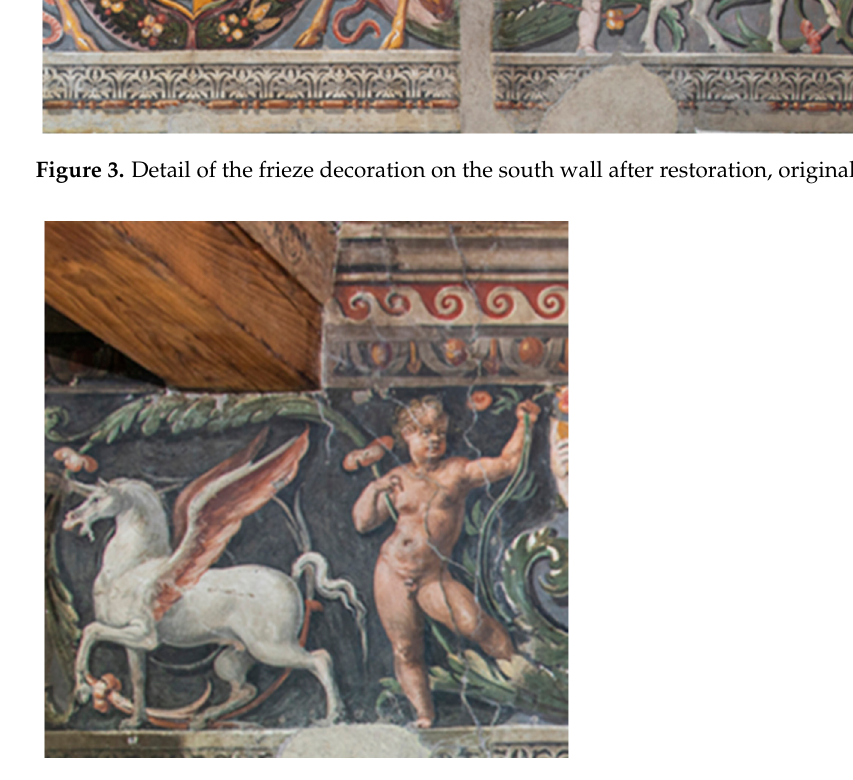
Figure 4. Detail of the ancient restoration after the present